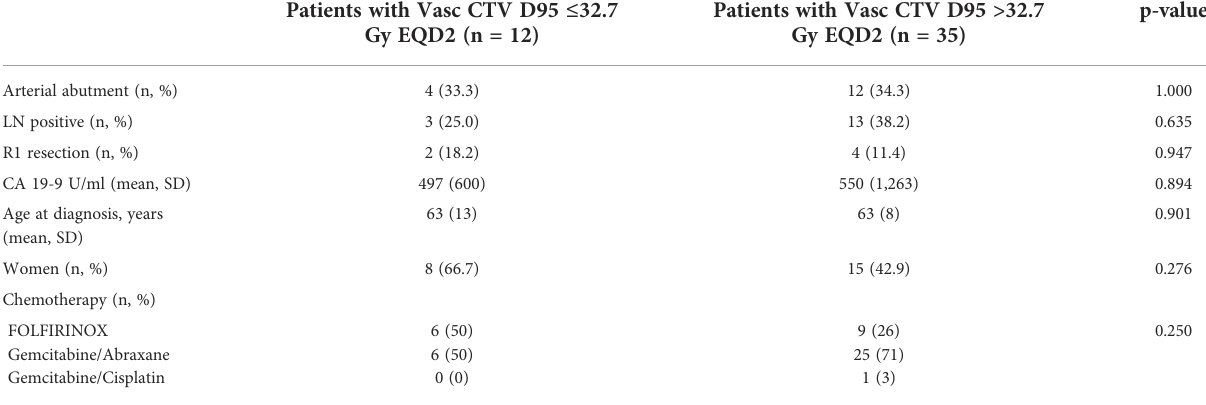
TABLE 2 Patient and tumor